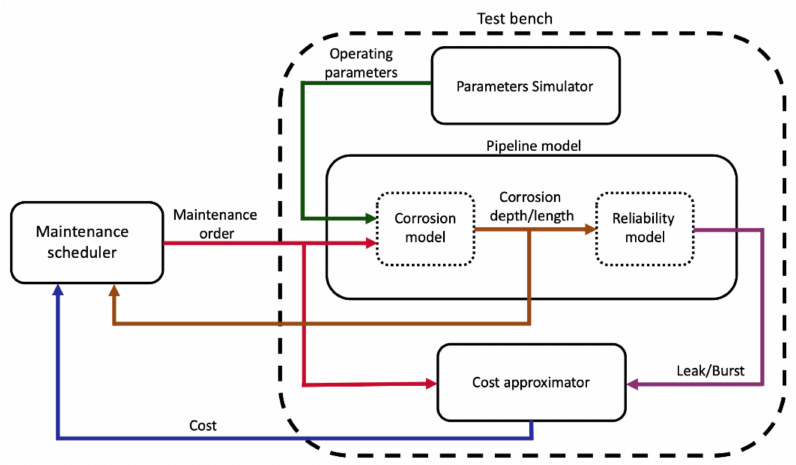
Figure 1. The proposed test bench for interaction evaluation between a maintenance decision-maker and a corrosive